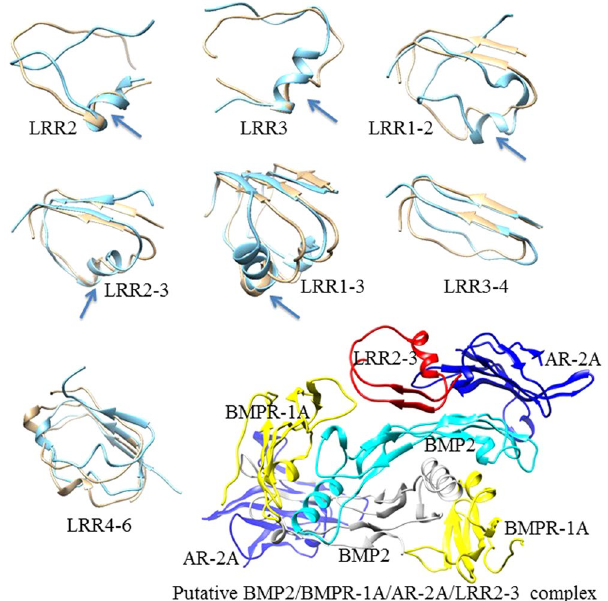
Figure 7. Molecular dynamic simulations. Representative snapshots of peptides from solution structure evaluations (in cyan). Also shown are the starting segments from X-ray crystal structures (in tan). An emergence of a helix in each structure during dynamics is indicated with the arrow in LRR2 (with a hinge), LRR3 (with a hinge), LRR1-2, LRR1-3, and LRR2-3 peptides. A putative model showing LRR2-3 interactions with the BMP2/BMPR-1A/AR-2A dimer system (LRR2-3 in red; BMP2 dimer in cyan and gray; BMPR type 1 A in yellow; activing receptor type 2 A in